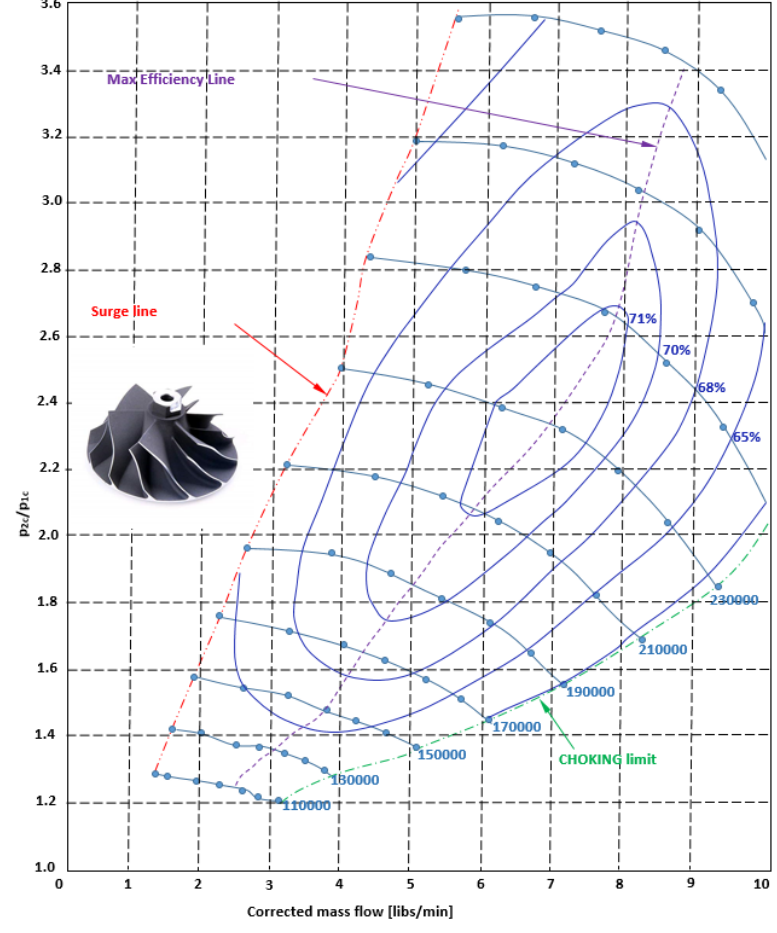
Figure 3. Operative compressor map. Table 2. Compressor (GT)12 compressor operation at different internal combustion engine (ICE) engine rotation regimes.